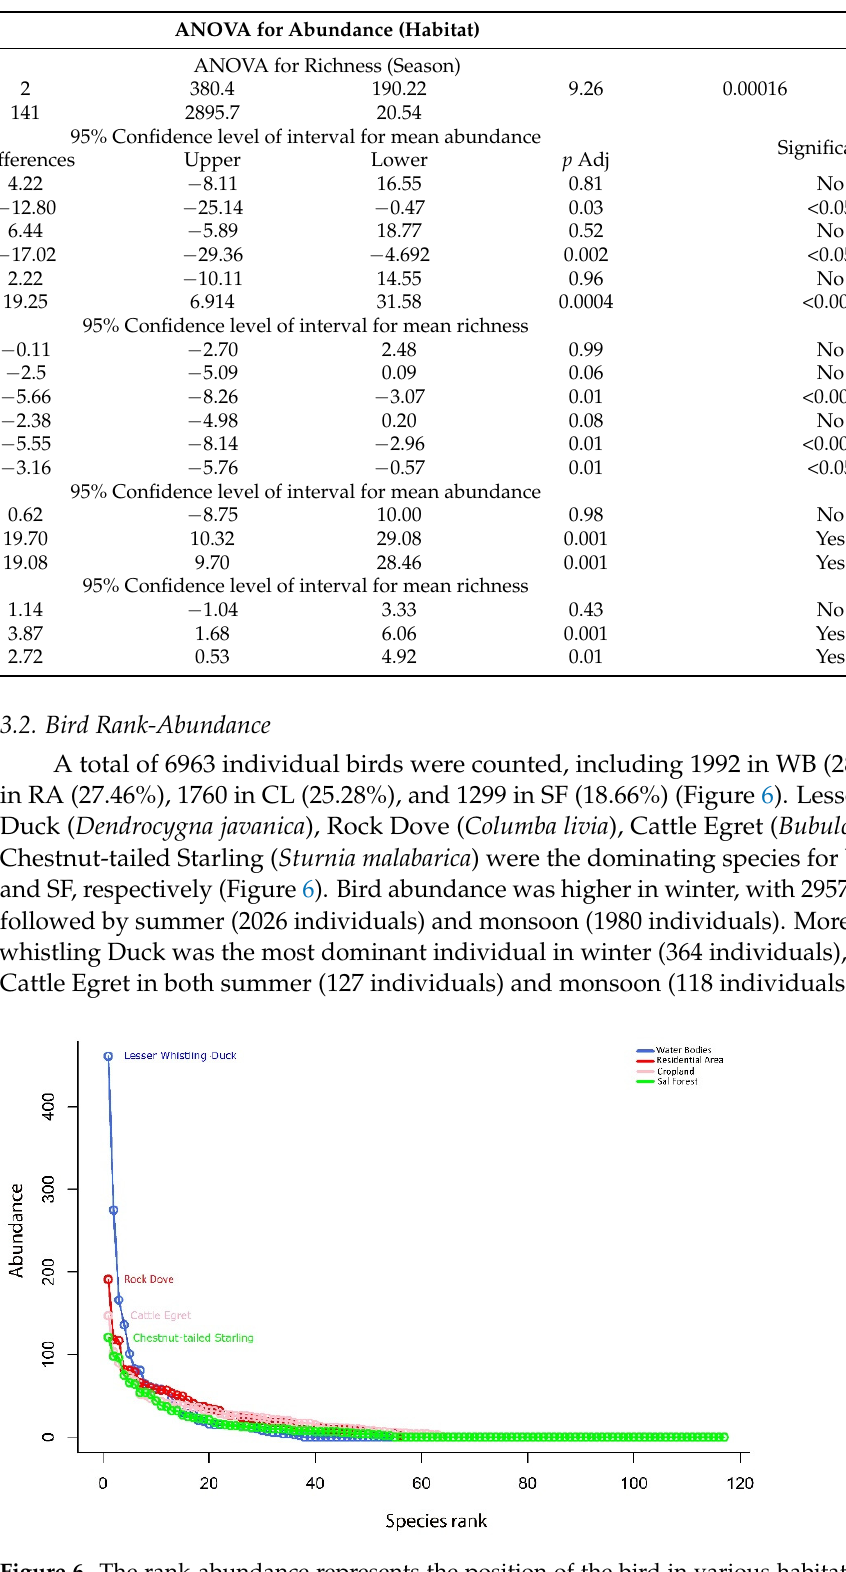
Figure 6. The rank-abundance represents the position of the bird in various habitats; the highest abundance of each bird in each habitat held the top position.